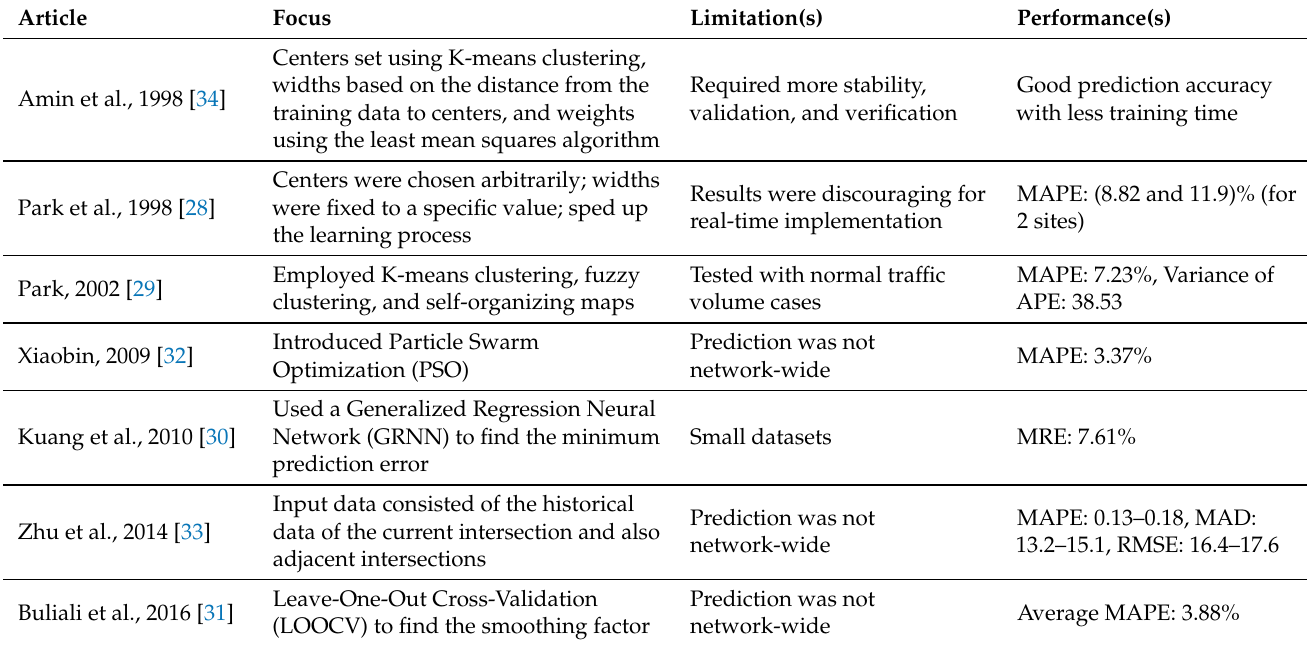
Table 2. Summary of the works found using